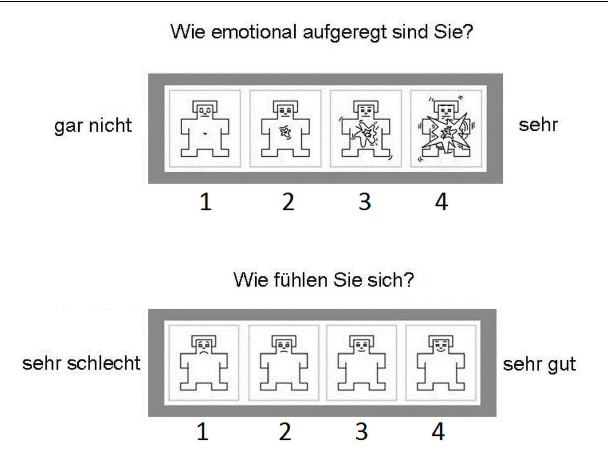
FIGURE 3 | The modified SAM rating scales as administered to the participants in the scanner. The participants could select directly one of the options on the four input buttons. The top scale is the arousal rating. The question above it asks, “How emotionally excited are you?” The options range from left “not at all” to right “very.” The bottom scale is the valence rating. The question above it asks, “How do you feel?” The options range from left “very bad” to right “very good.”